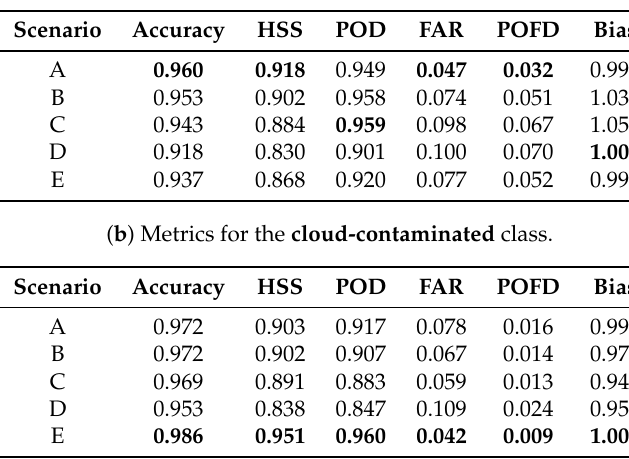
Table 5. Statistics for 7977 test scenes from 2011. ( a ) Metrics for the cloud-free class